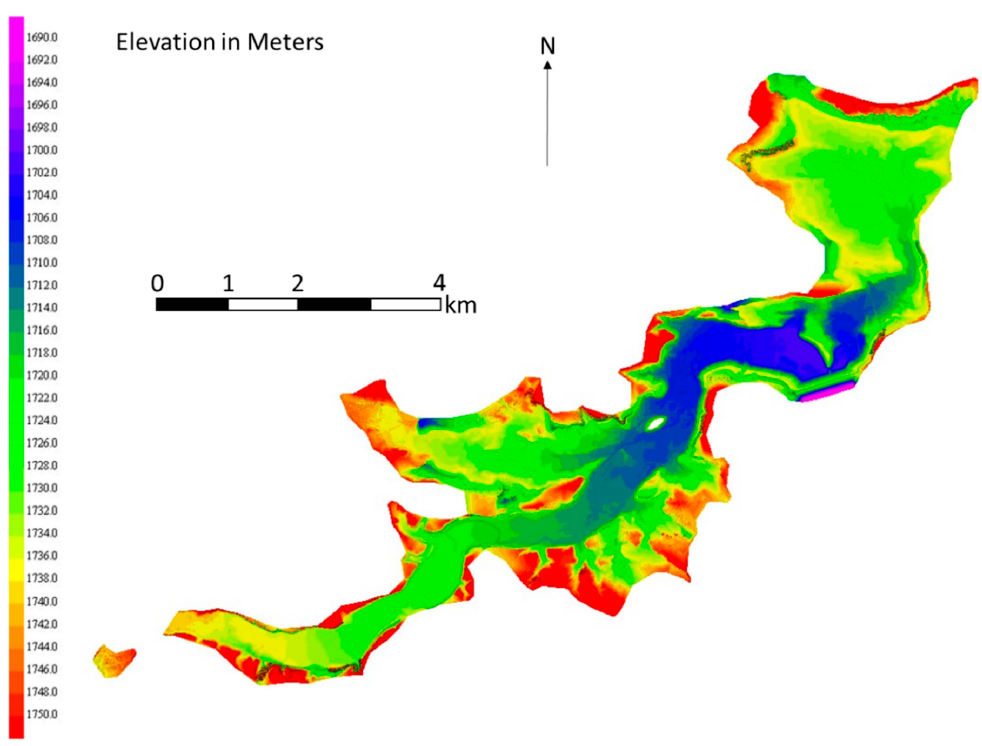
Figure 15. Digital terrain model of Starvation Reservoir.